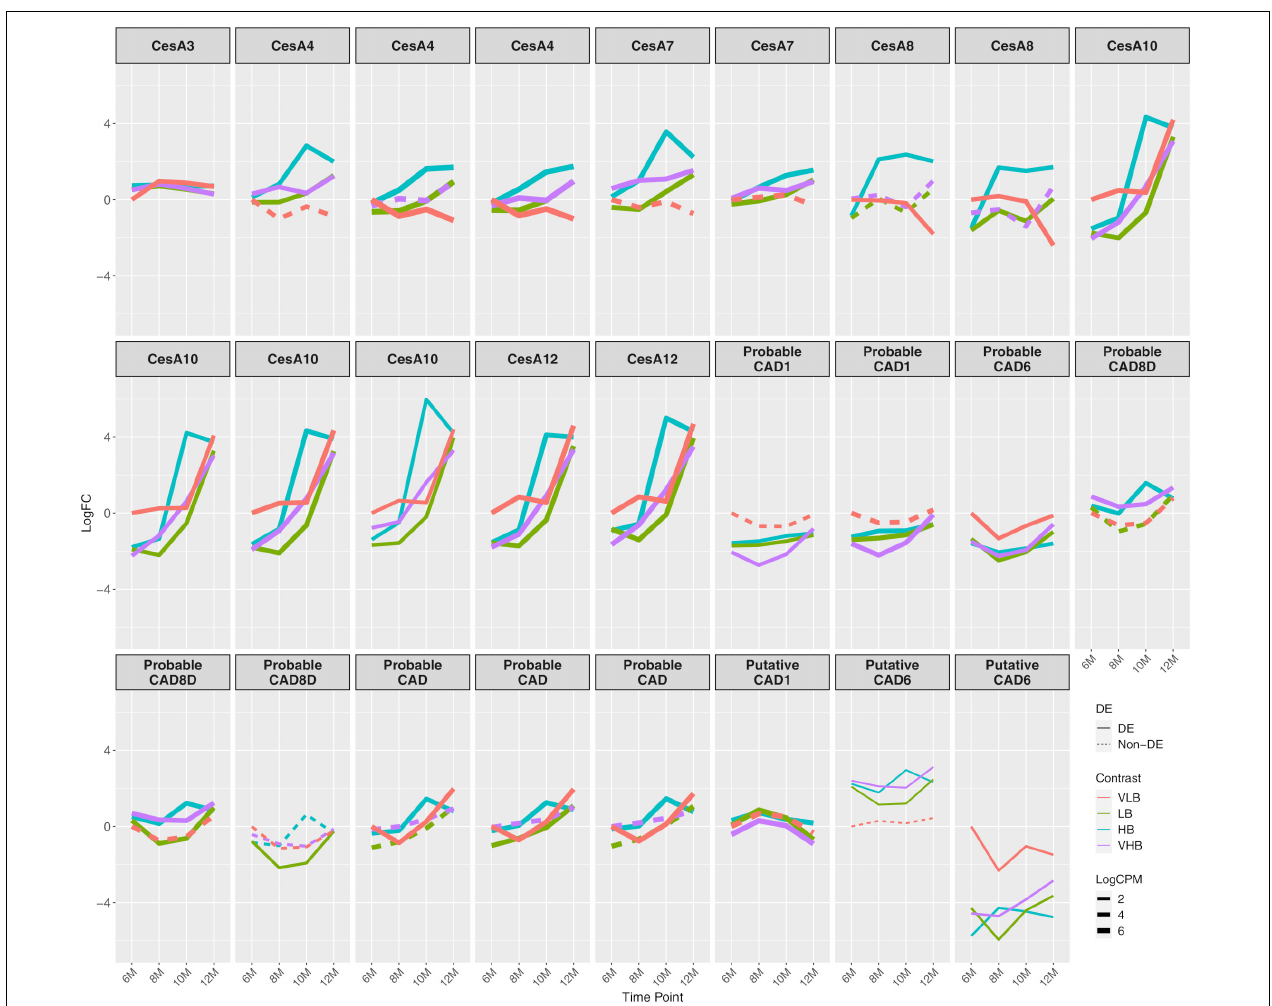
FIGURE 3 | Expression profiles of genes related to the biosynthesis of cell wall components. The x axis shows the age of plants (in months). The y axis corresponds to the log fold change in comparison to the very low ◦ Brix (VLB) genotype in T1 (6-month-old plants). Each line represents a gene and the solid lines indicate genes with significant differential expression in at least at one time point, while dashed lines represent genes with no differential expression for a given genotype. The line width indicates the average expression level of each gene, with more highly expressed genes thicker. CesA and CAD correspond to cellulose synthase and cinnamyl alcohol dehydrogenase, respectively. VLB: very low ◦ Brix, LB: low ◦ Brix, HB: high ◦ Brix and VHB: very high ◦ Brix.